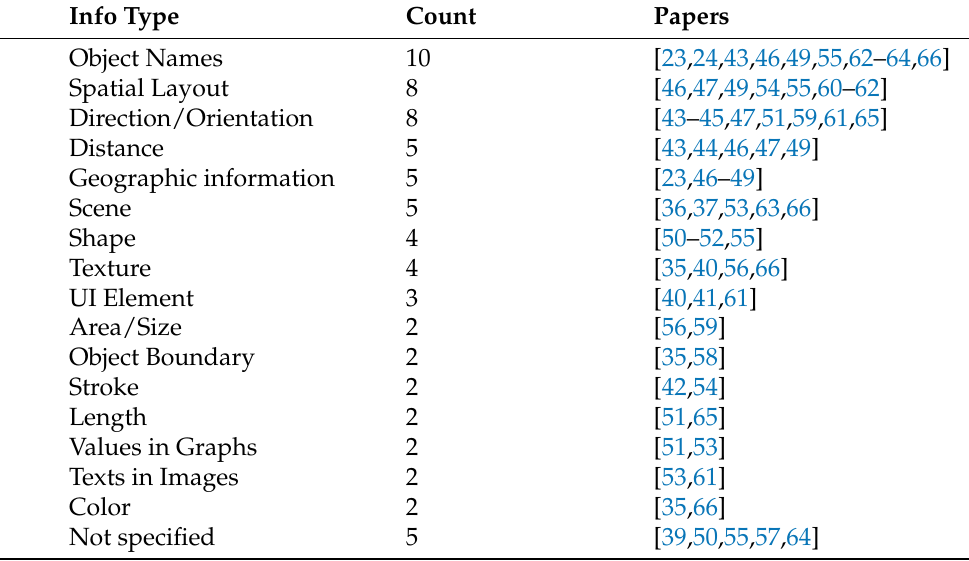
Table 2. Types of information provided to improve image